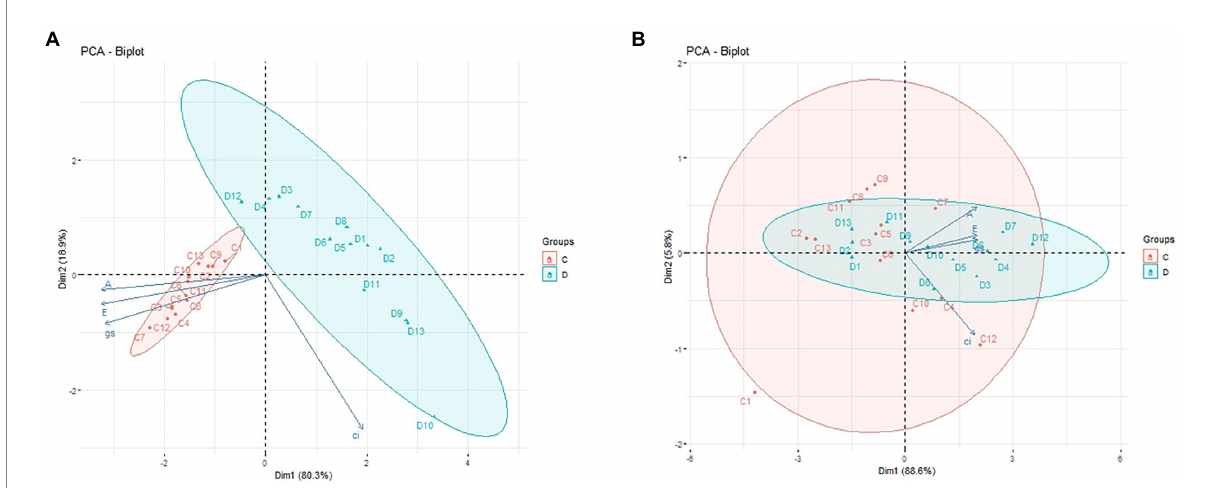
FIGURE 3 PCA of plant photosynthesis parameters. Projection of the variables on the component plane (1 × 2): (A) —during drought stress; (B) —after plant regeneration. C, control (well-watered); D, drought stress; 1–13: seed treatments (Table 1). Each of the vectors represents one variable, and their sizes and directions describe the effects they have on the major